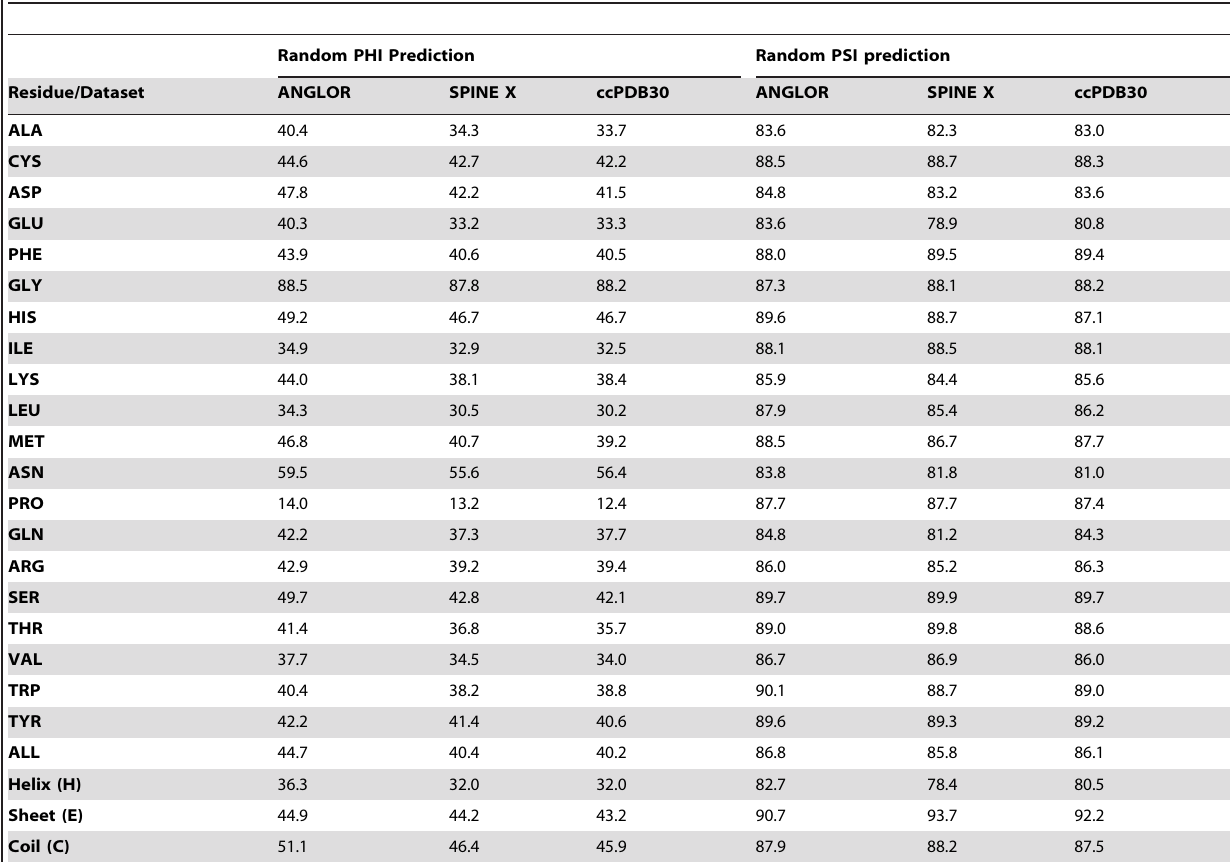
Table 3. Performance of random prediction method, in terms of MAE, on ANGLOR, SPINE X and ccPDB30 datasets for the prediction of phi and psi dihedral